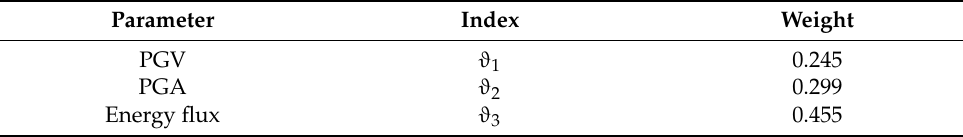
Table 1. Weight distribution table for each